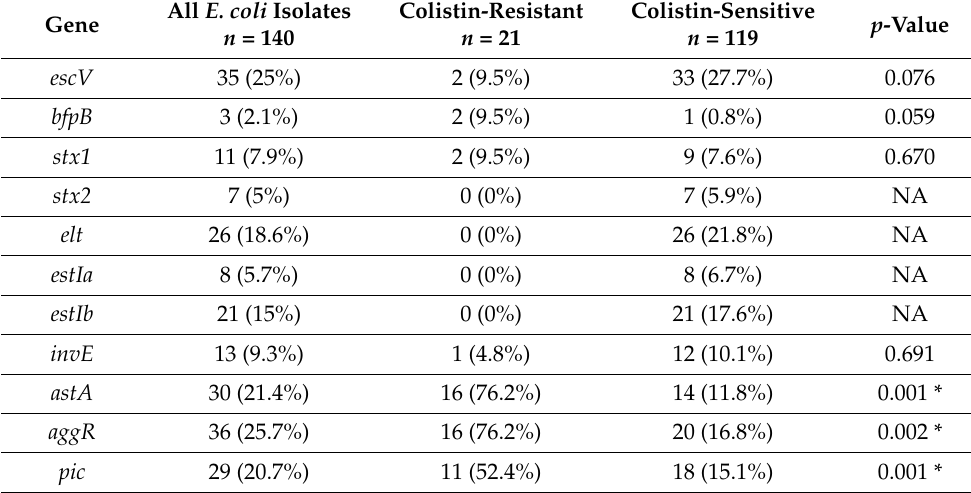
Table 4. Distribution of virulence-related genes among E. coli